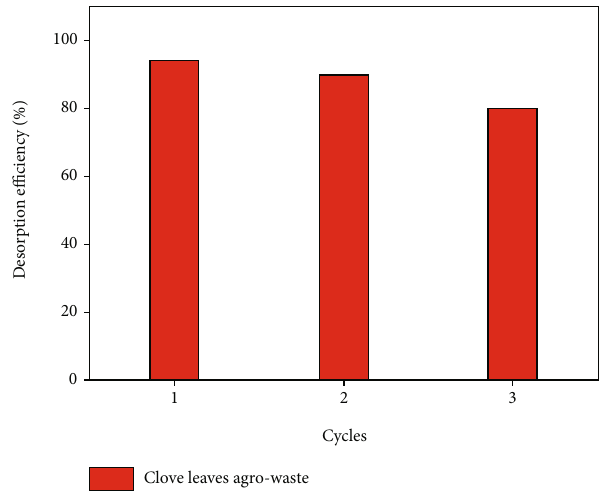
Figure 12: The cycles of adsorption-desorption of